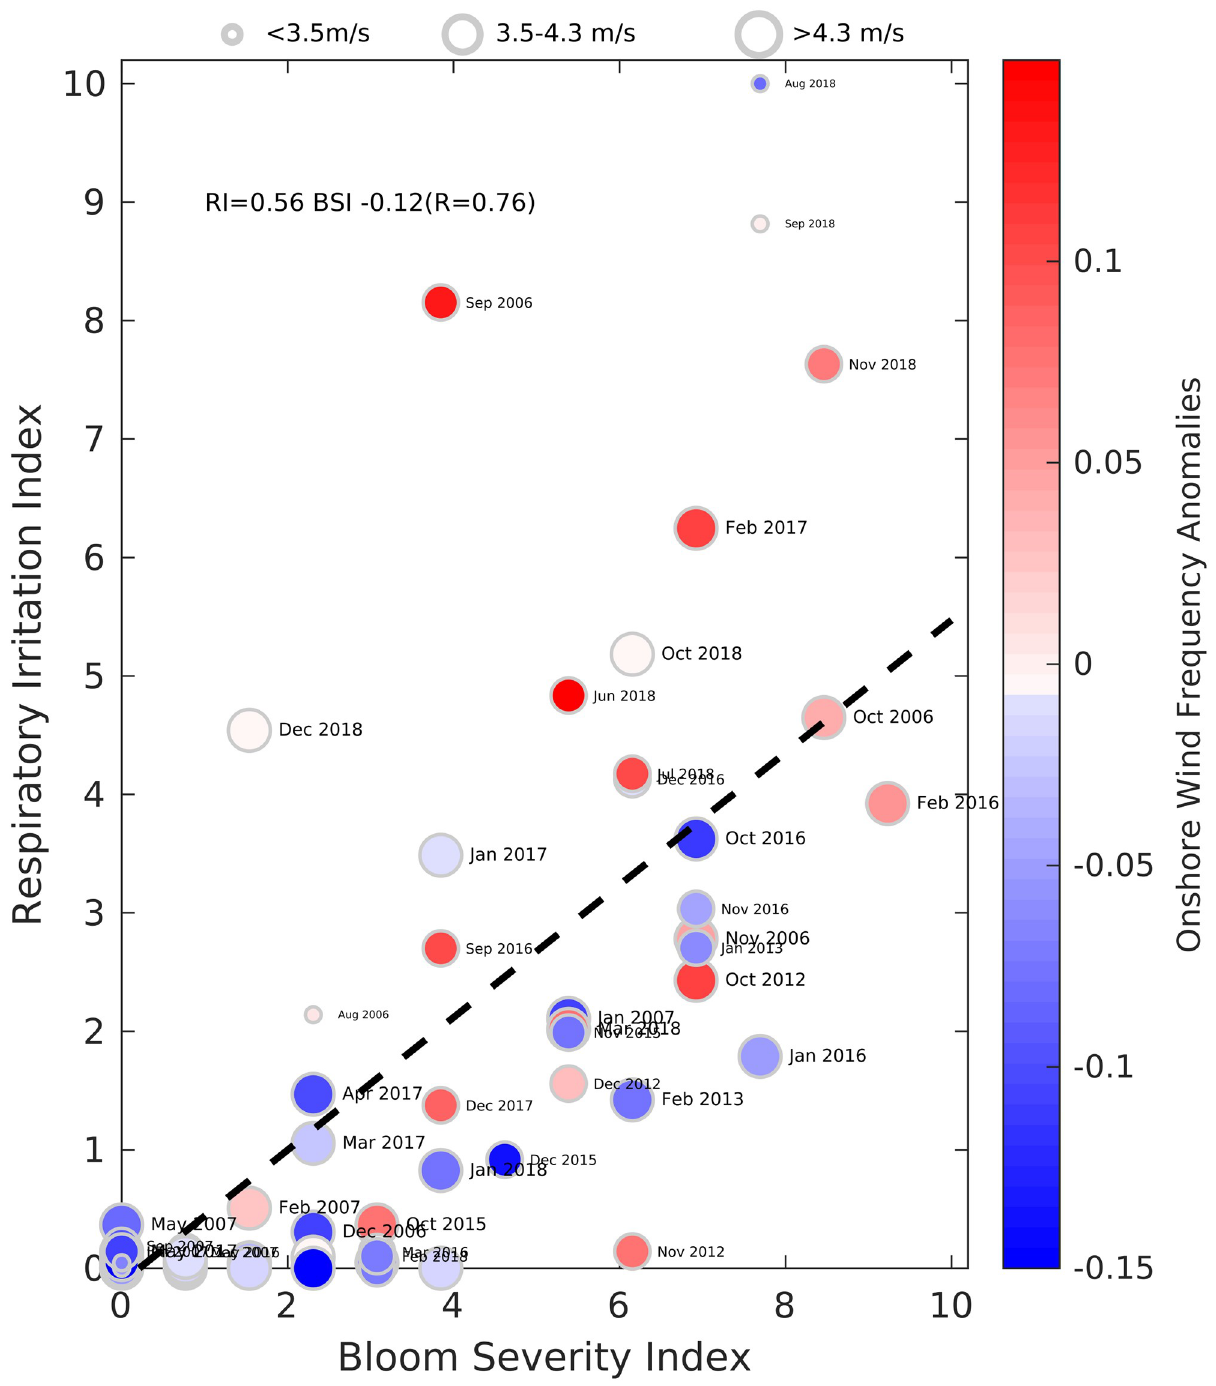
Fig 11. Relationship of monthly respiratory irritation impact (RI) index, monthly bloom severity index (BSI), and winds. The relationships are shown for cell counts > 50,00 cells L -1 for Manatee and Sarasota Counties, FL. Color-coding represents the onshore wind frequency anomalies (OWFA) for each month, positive (red) indicates onshore, and negative (blue) indicates offshore. Months when bloom were not observed were not shown. Size of the circles represent the wind speed for the month. April-June 2007 were not included because respiratory irritation during those months was caused by the Bugaboo Scrub wildfire. Black dashed line shows the linear regression fit between the monthly RI and BSI (equation shown).